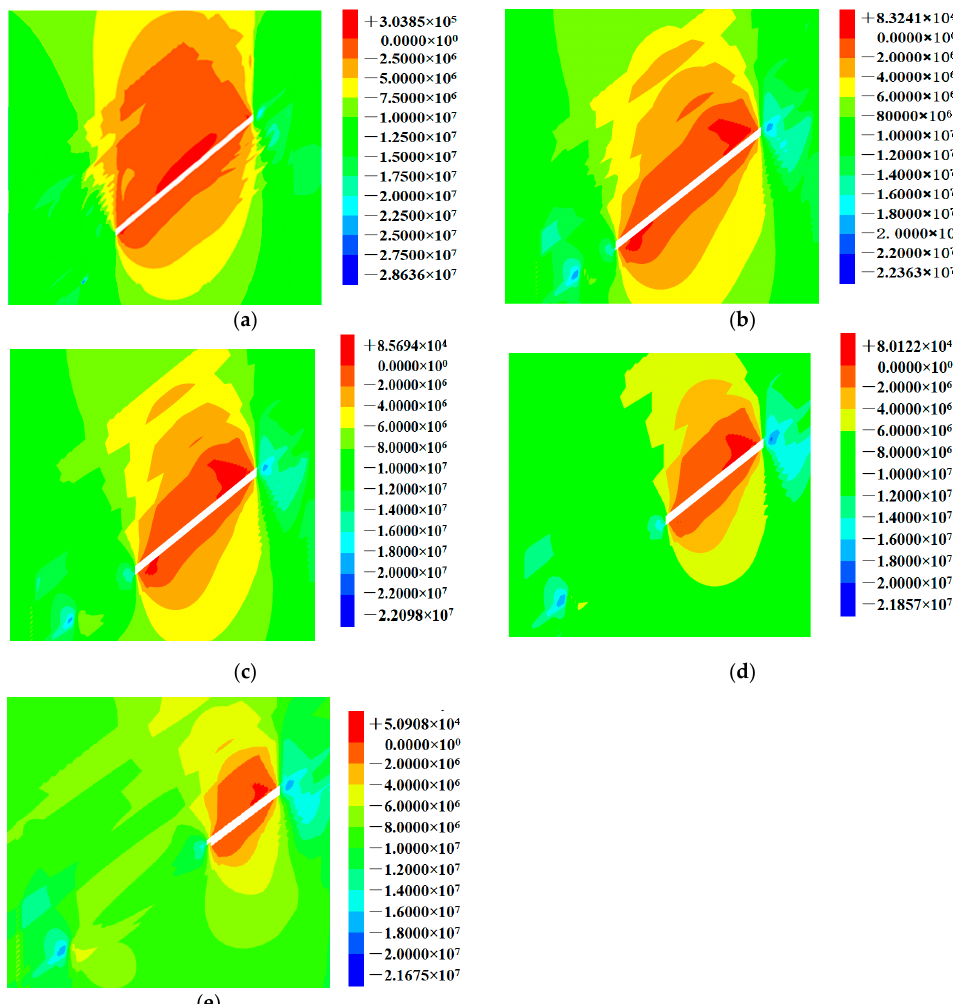
Figure 3. Vertical stress characteristics of overburden under different filling quantities. Different colors represent different vertical stress values as shown in the right legend. ( a ) No filling; ( b ) Filling 1/5; ( c ) Filling 1/3; ( d ) Filling 1/2; ( e ) Filling 2/3 .